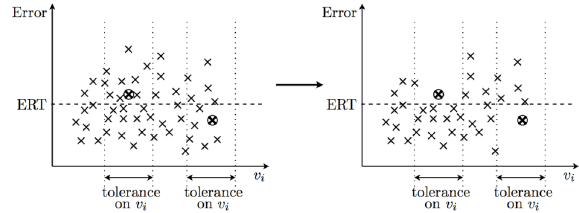
Fig. 16. Clustering operation on the FL learning data, around the two circled points, with respect to 1 FL input. In practice, points are removed only if the illustrated condition is fulfilled for all the FL